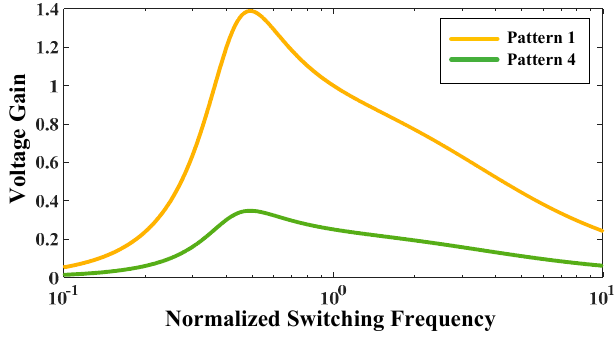
Figure 9. Voltage gain curves of Switching Patterns 1 and 4.